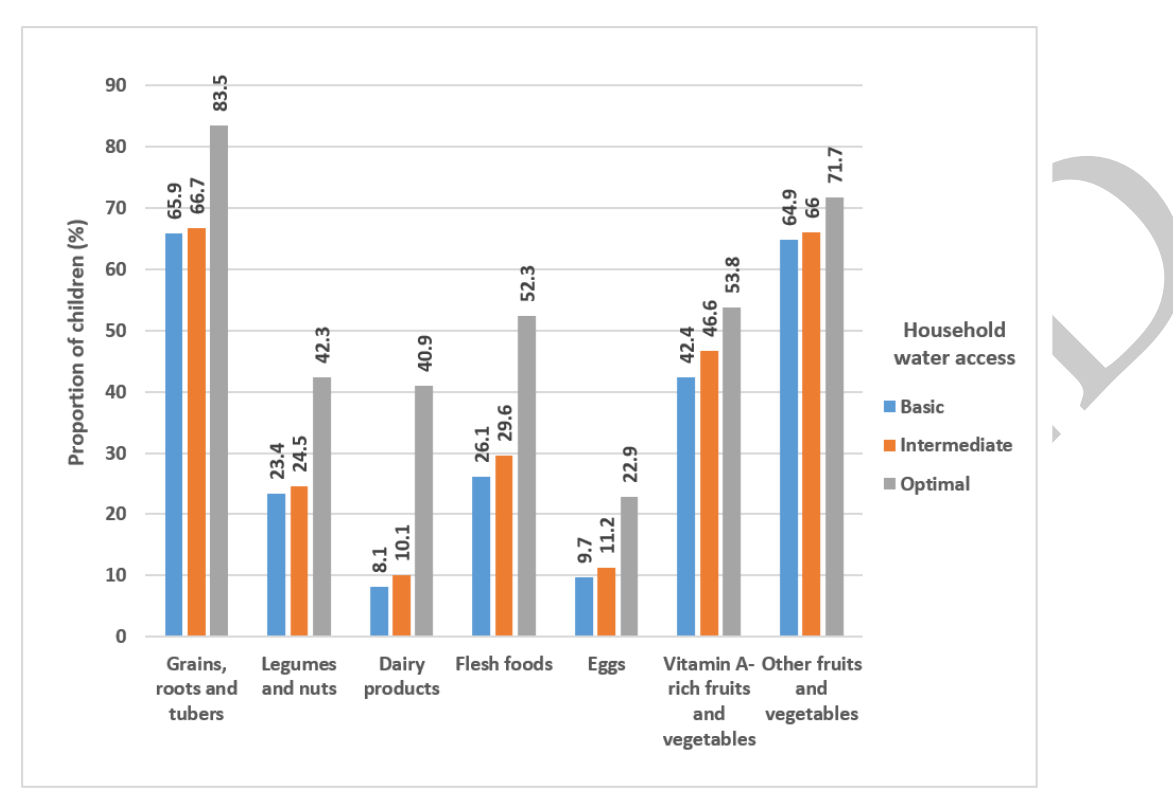
Figure 1. Infants’ and young children’s food consumption proportions per food group relative to household water access. Table 3. Association between household water access and minimum dietary diversity among children aged 6–23 months in Malawi. Crude and adjusted odds ratios based on generalized estimating equation (GEE)-fitted logistic regression analysis ( n =